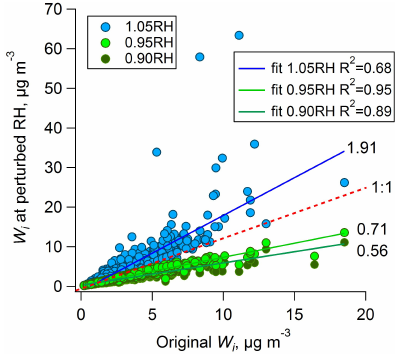
Figure 7. W i based on artificially perturbed RH at upper and lower uncertainty limits compared to W i at base level. 1.10RH (i.e., RH increased by 10%) is not plotted because it results in much larger W i than the rest. Slopes and R 2 indicate corresponding W i uncer- tainty caused by variability (uncertainty) in